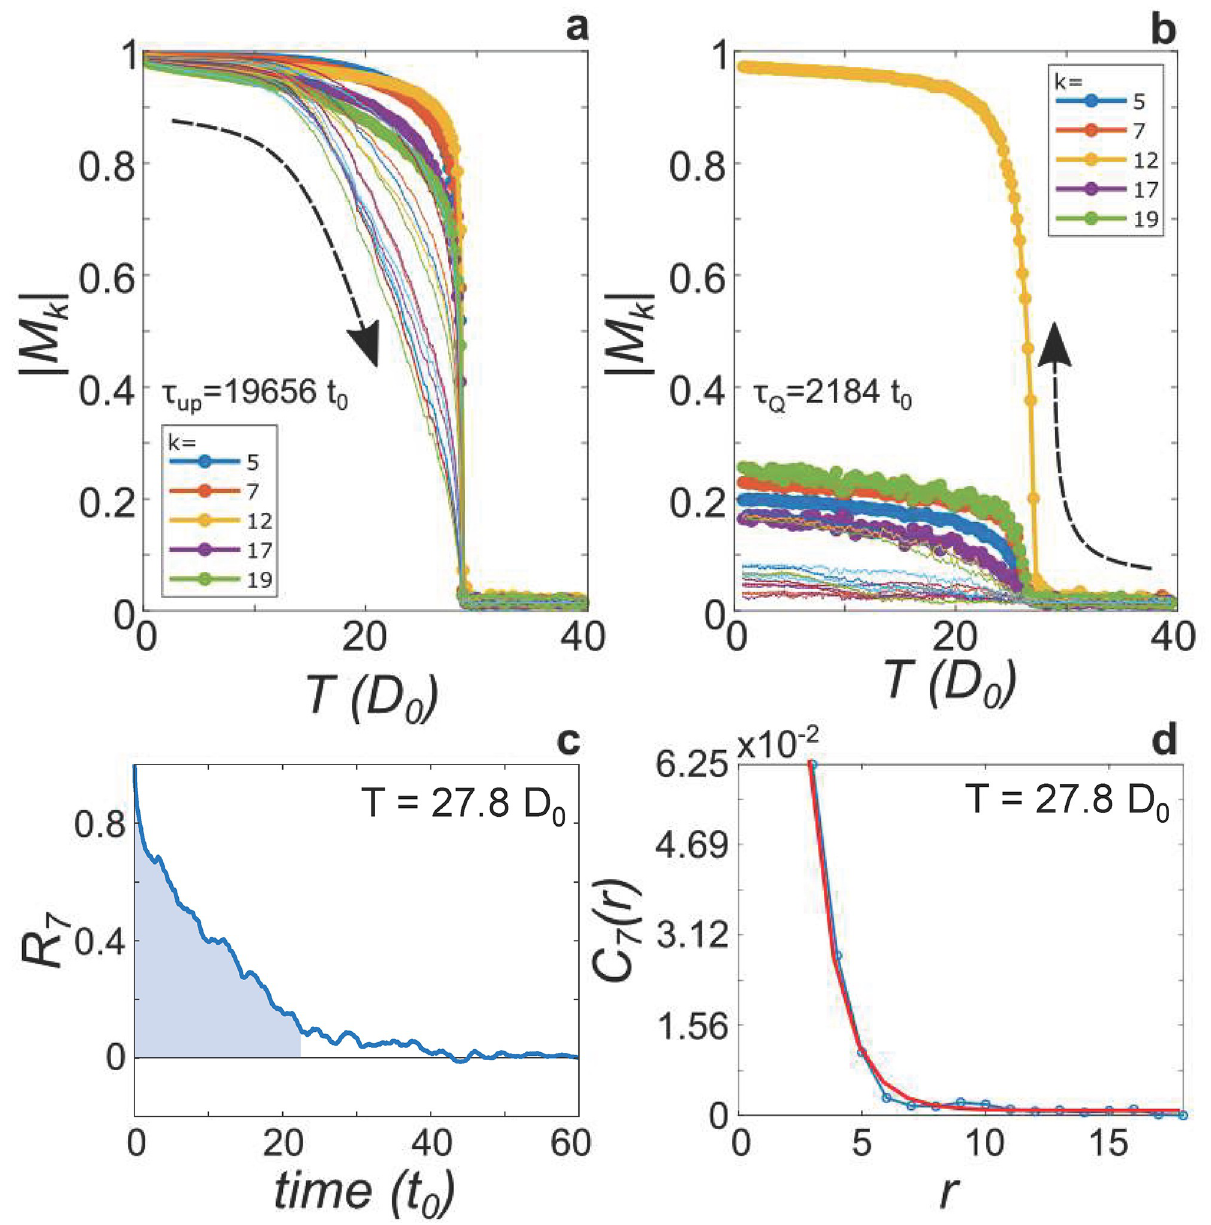
Fig 3. Parameter extraction. (a) Magnitude of order parameters | M | vs. T for a slow temperature sweep up, showing k = 1 − 20. Prominent values of k k are indicated in legend. (b) Same as (a) but for a faster quench down. (c) Example of determination of one value of τ as the area of the shaded region under the curve of the magnitude of the autocorrelation R 7 ( t ) of the M 7 order parameter over time until R 7 first crosses 0.1. (d) Example of determination of one value of ξ by performing an exponential fit to the correlation function C 7 ( r ). Due the finite system and simulation time, both R k and C k have small imaginary parts that we